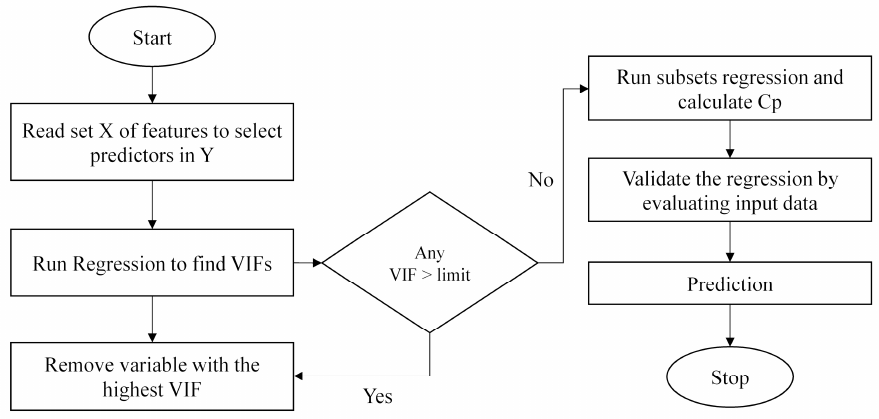
Figure 8. Algorithm flowchart of using MLR for modelling the landslide chances.